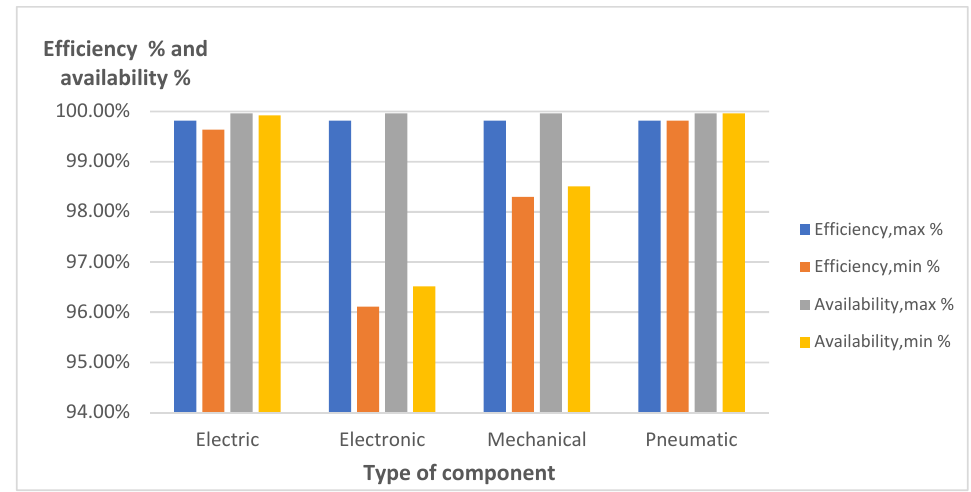
Figure 6. Maximum and minimum efficiency and availability values in % by component type with the IPPM strategy.